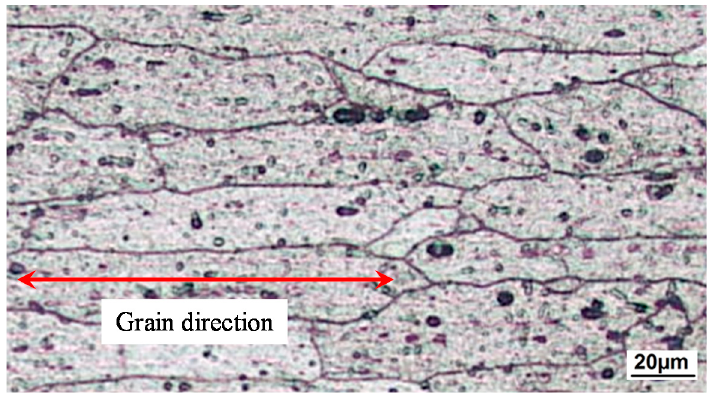
Figure 8. Grain orientation in a burnished sample within the HAZ near the top surface of the sample.